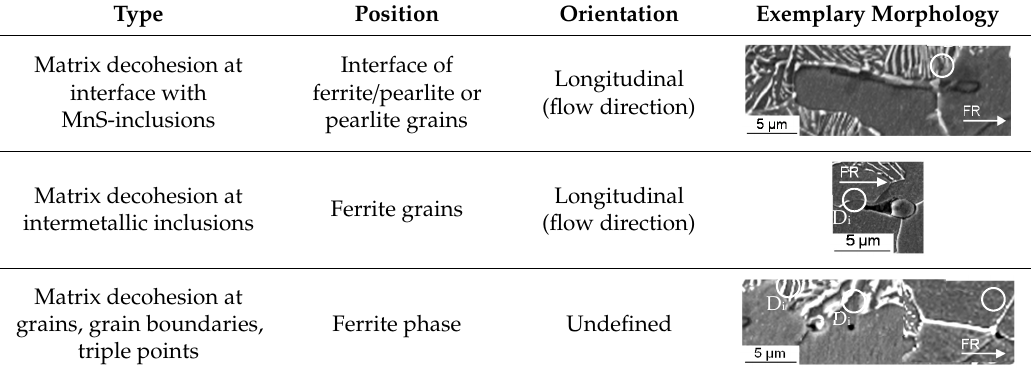
Table 2. Types, location and orientation of forming-induced initial damage (D i ) in the material states E.530 / E.590 with respect to the fiber direction after extrusion (FR), with the decohesion of the interface between metallic matrix and MnS-inclusions as the main type of initial damage ( > 95%).